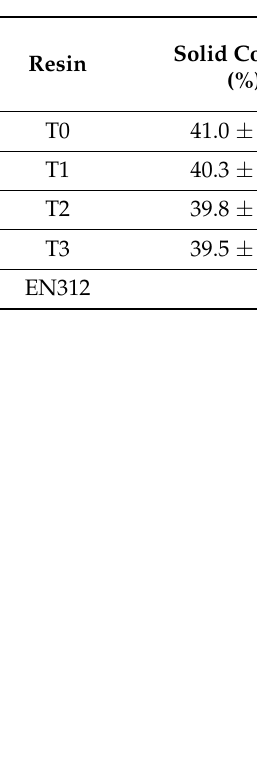
Table 3. Average results of tests of particleboard panels bonded with T0, T1, T2, and T3